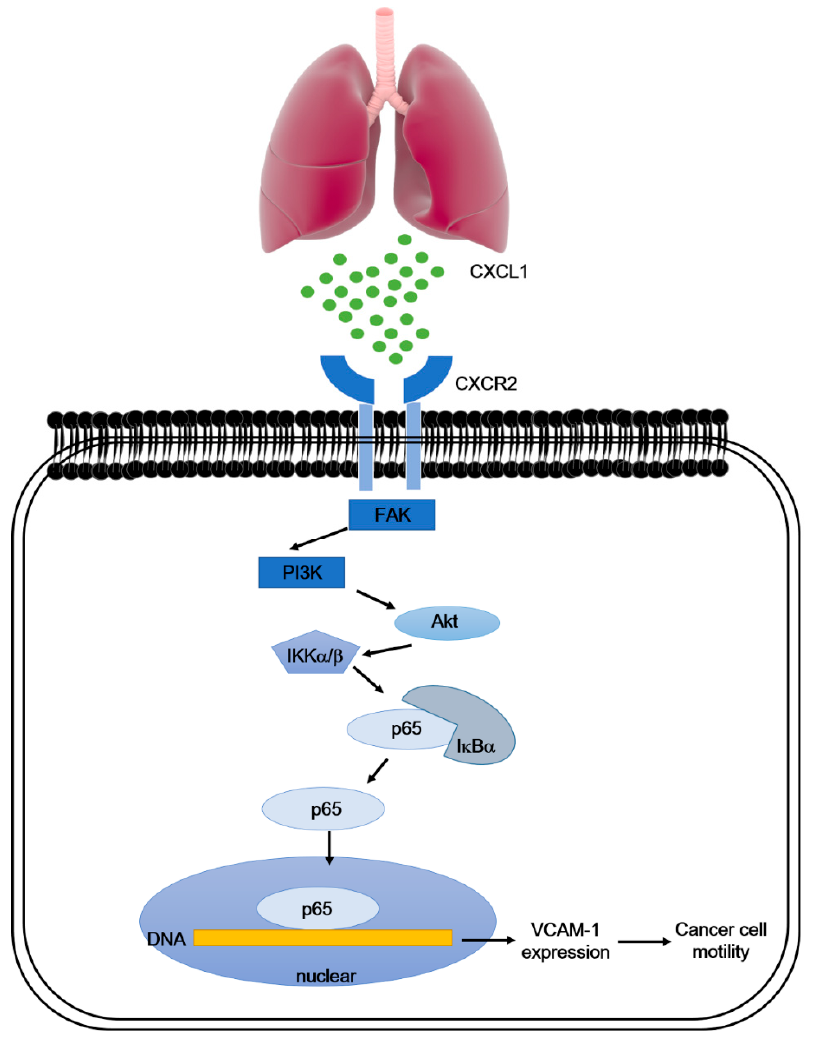
Figure 7. Schematic diagram summarizes the mechanism whereby CXCL 1 promotes VCAM-1 expression and cell migration in osteosarcoma. High levels of CXCL1 secreted by human pulmonary artery endothelial cells (HPAECs) promoted osteosarcoma cell mobility. When HPAECs conditioned